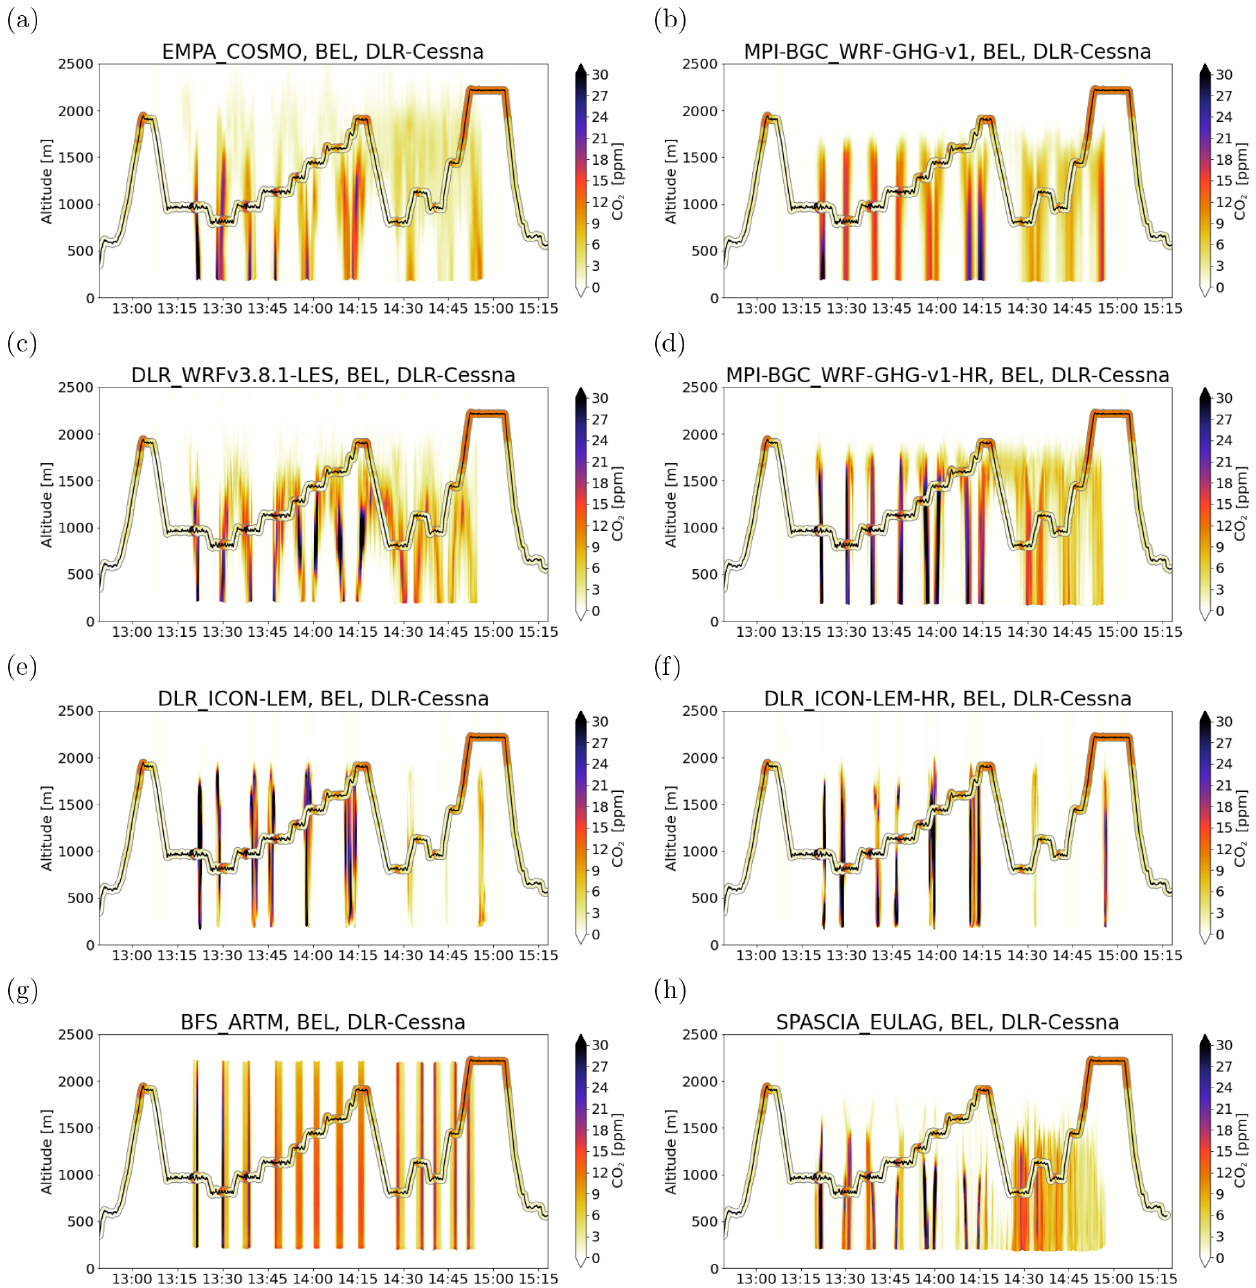
Figure 4. Curtains of the Bełchatów CO 2 plume along the DLR Cessna flight on 7 June 2018. Figures show the middle release tracer